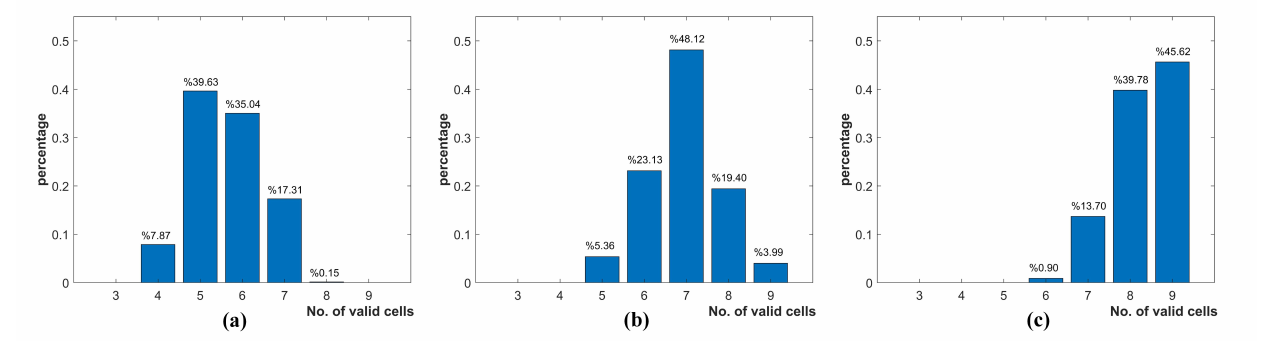
Figure 14. Percentage of solar cells with valid measurement when the threshold of ( a ) 65 ◦ , ( b ) 75 ◦ and ( c ) 85 ◦ are imposed